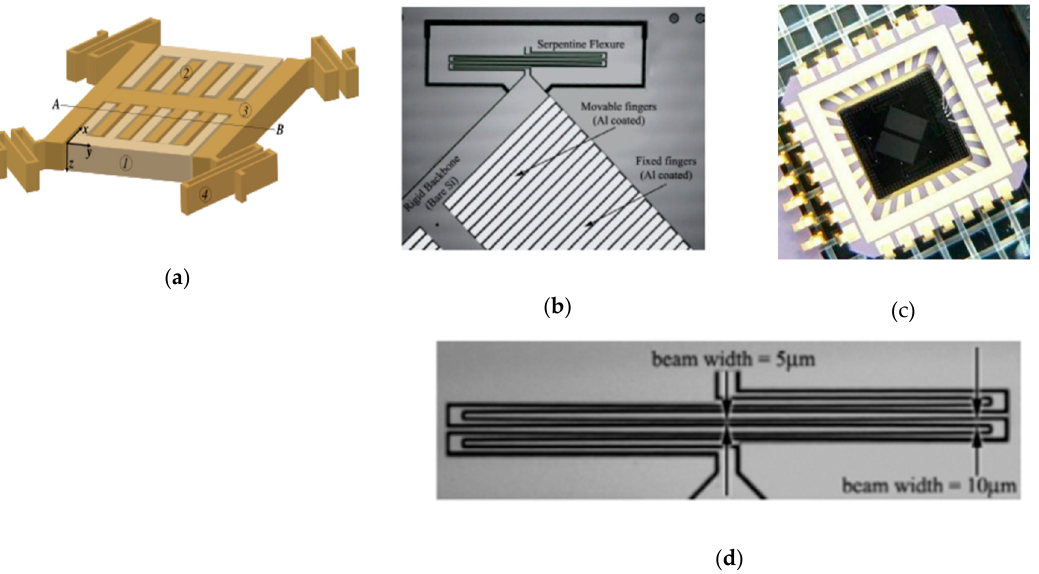
Figure 16. An electrostatic actuator for Lamellar grating based FTS: ( a ) FTS structure schematic: (1) Fixed fingers, (2) Movable fingers, (3) Rigid backbone, (4) Folded flexures; ( b ) fabricated MEMS device; ( c ) packaged device; ( d ) closed-up view of the serpentine flexure. (Reprinted with permission from References [39,40] IOP Publishing, Ltd.).